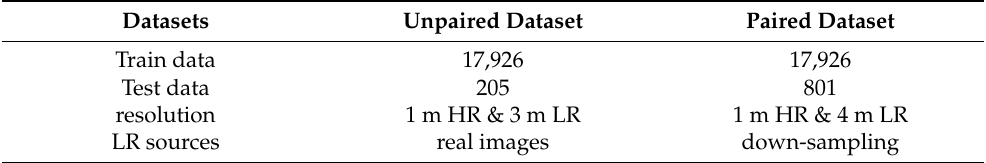
Table 1. The details of unpaired datasets and paired